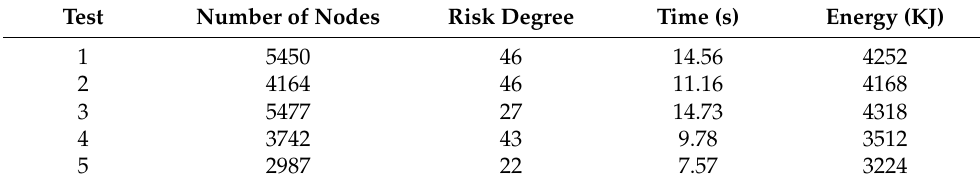
Table 4. Comparison of Motion Planning Test.